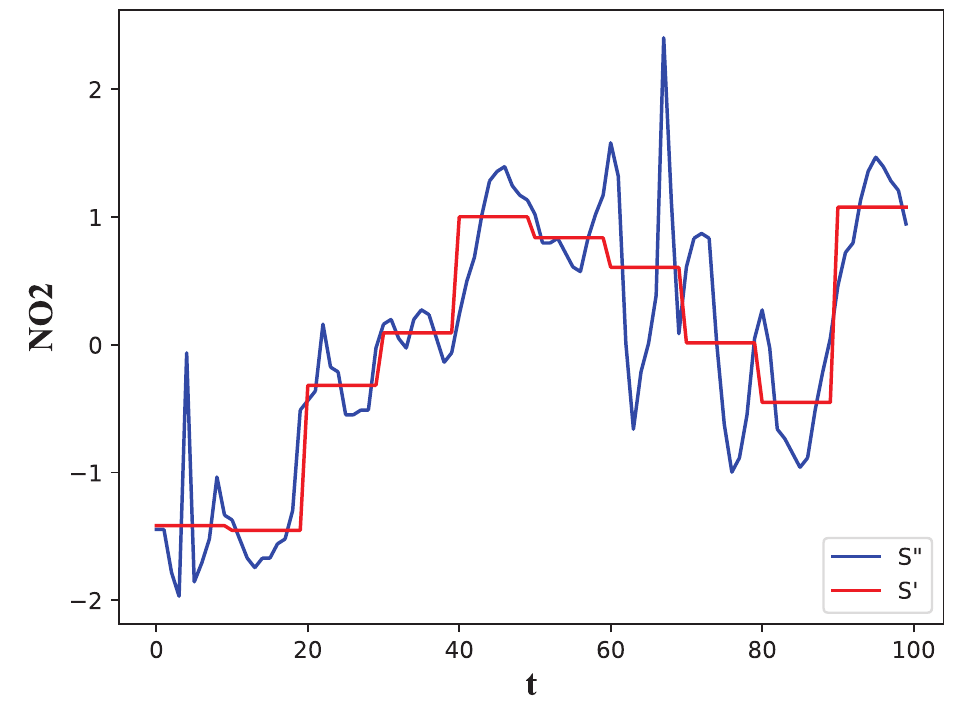
Figure 1. The original numerical MTS and